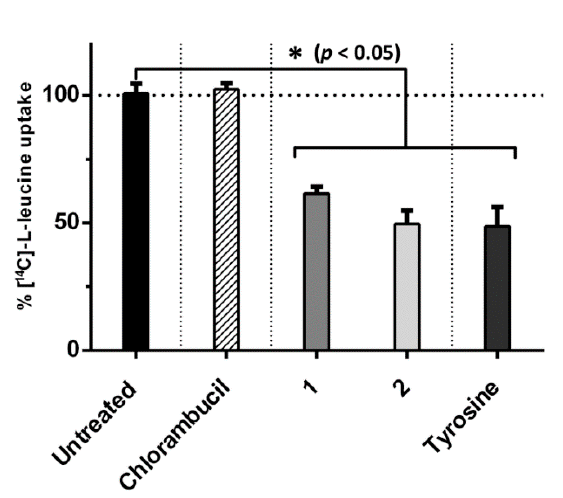
Figure 3. Ability of chlorambucil and its derivatives 1 and 2 (10 µ M) to inhibit uptake of [ 14 C]- l -leucine (0.157 µ M) in MCF-7 cells. All data presented as mean ± SD ( n = 3). * p < 0.05, significant di ff erence compared to untreated control .